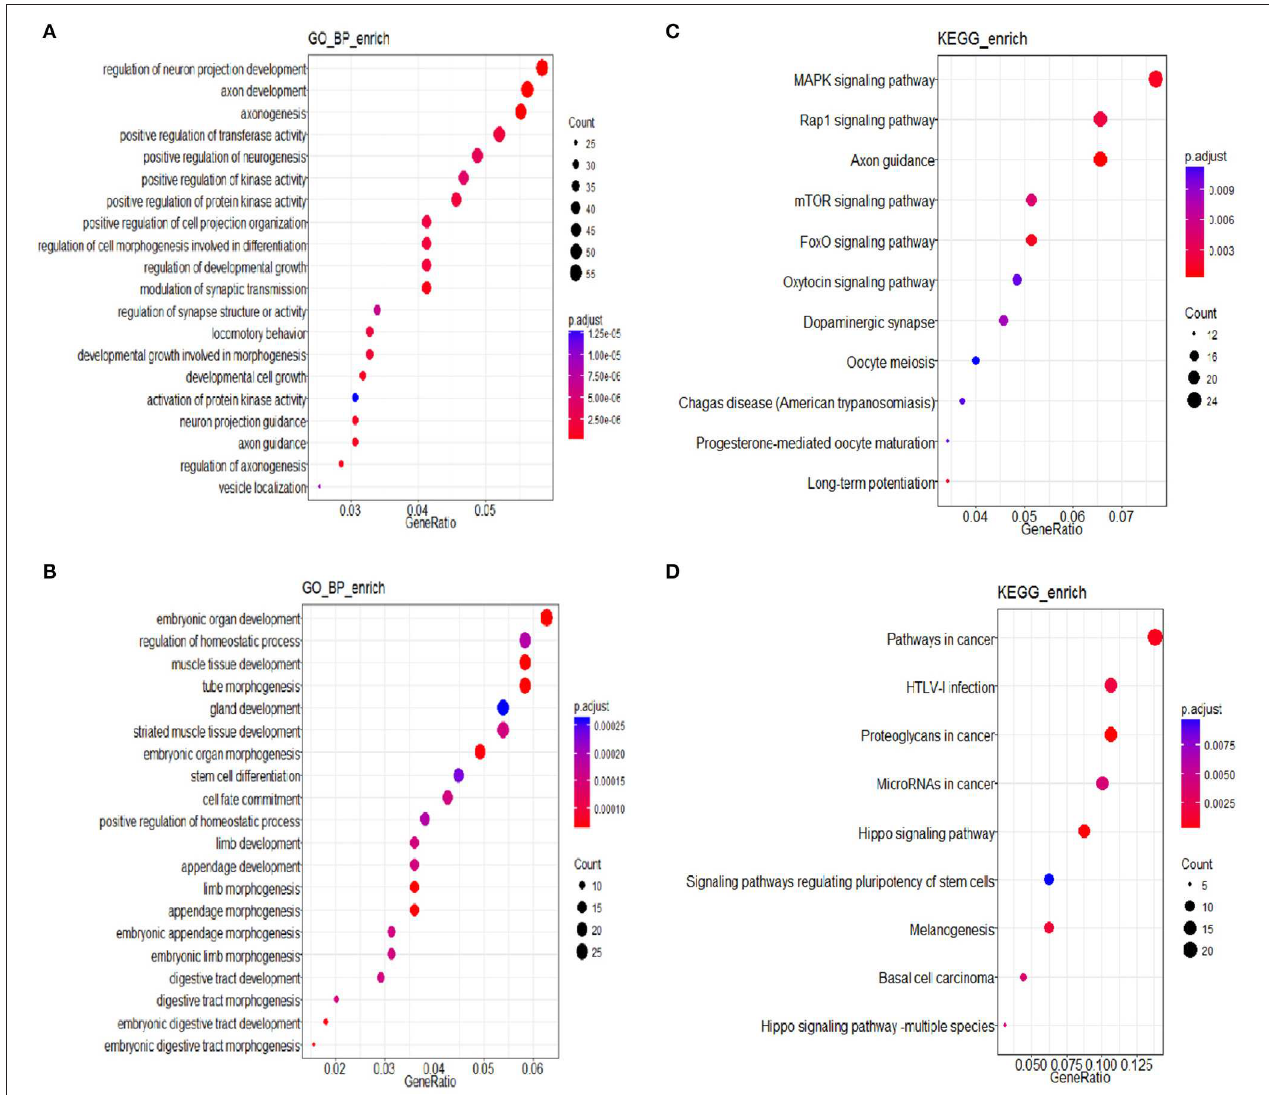
FIGURE 4 | (A,B) miRNAs related differentially expressed genes (DEGs) involved in Gene Ontology (GO) Classification; (C,D) Kyoto Encyclopedia of Genes and Genomes (KEGG) pathways of miRNA related